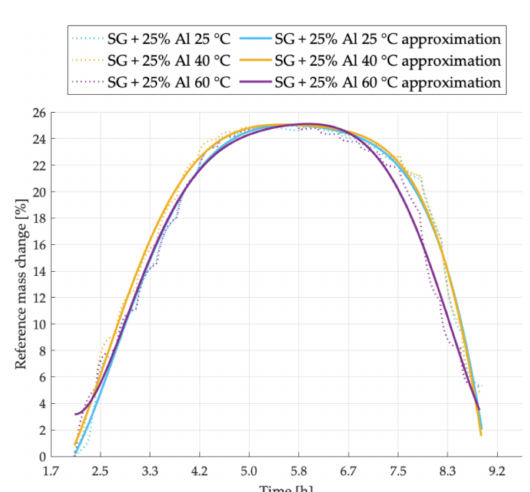
Figure 3. Sorption kinetics graph for SG + 15% Al sample tested at temperatures of 25 ◦ C, 40 ◦ C, 60 ◦ C.